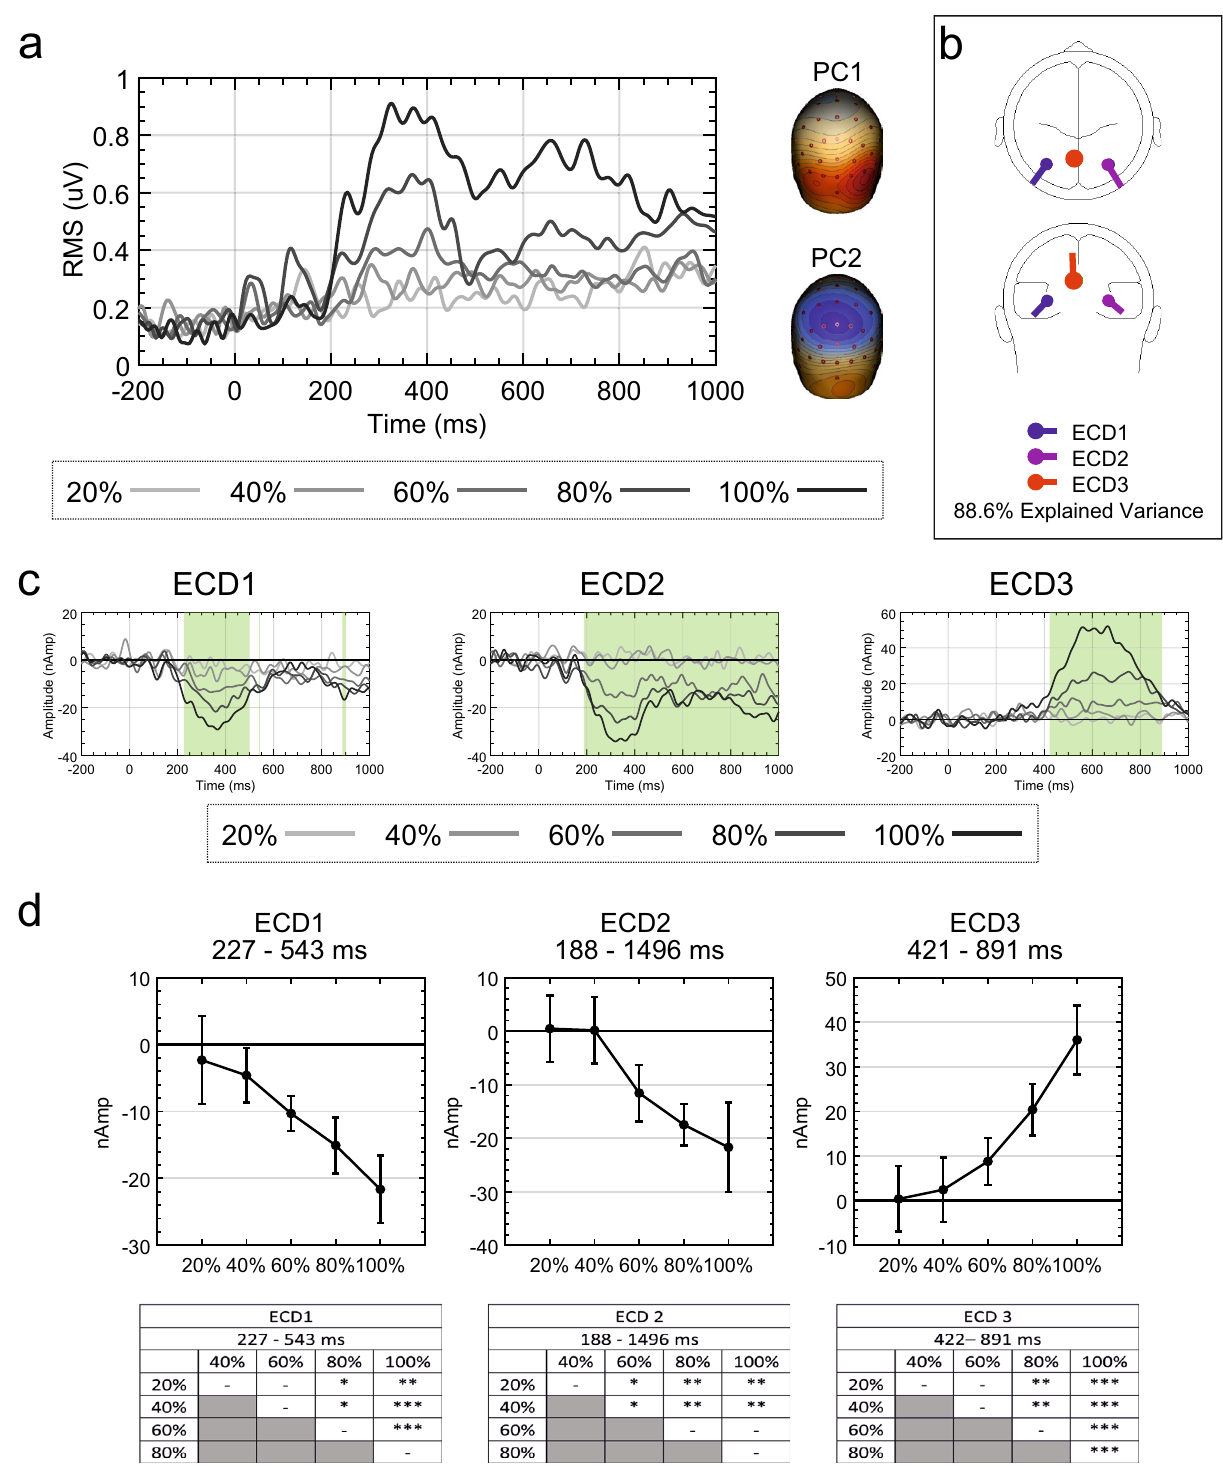
Figure 11. Source dipole model residual variance, source waveforms and mean activity in intervals for Palumbo et al. 32 . ( a ) Residual variance GFP for each condition when including only extrastriate sources and the two principle components explaining the greatest amount of variance. ( b ) Final source dipole model and proportion of explained variance. ( c ) Source waveforms for each ECD from each condition. Significant main effects of PSYMM are highlighted in green. ( d ) Mean source activity averaged over latencies demonstrating significant main effects of PSYMM for each task and ECD. Results of post-hoc testing are also shown (*P < 0.05; **P < 0.01; ***P < 0.001). Scalp maps and glass brains were created using BESA 7.0 (https